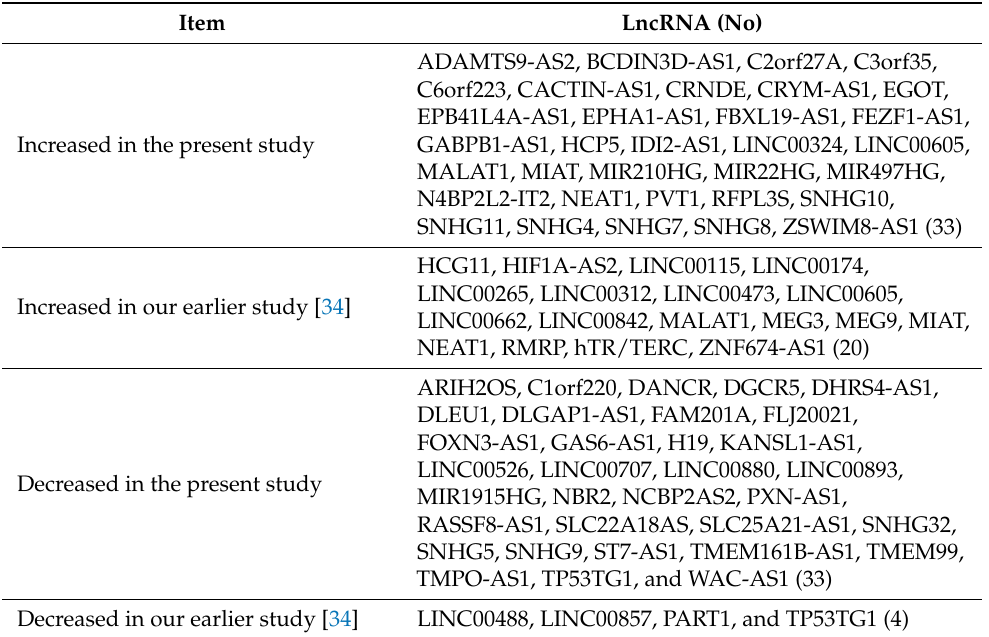
Table 1. Altered expression of lncRNAs in cells transfected with SARS-CoV-2 infected cells or tissues from COVID-19 patients in more than one